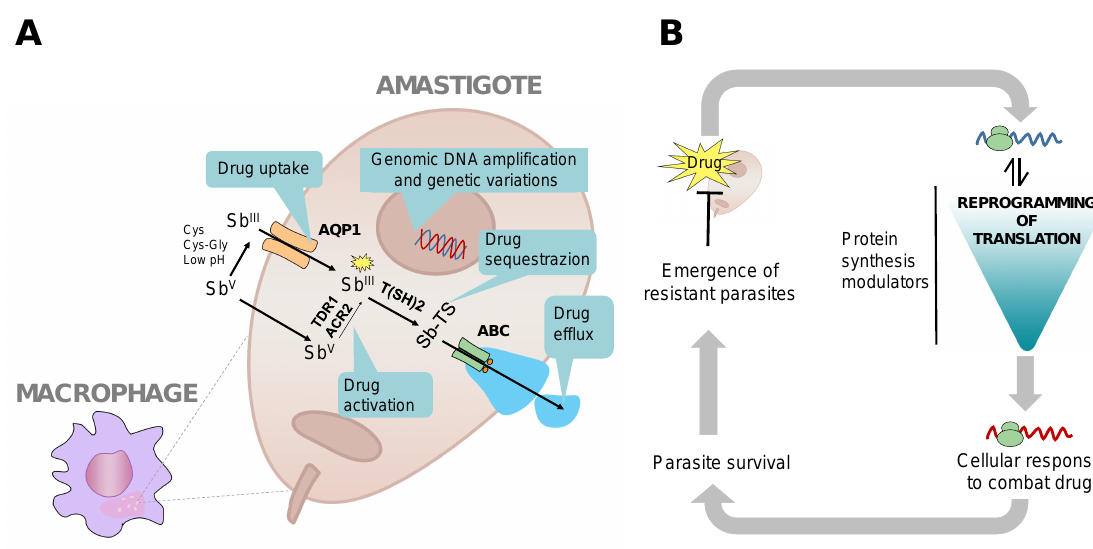
A schematic representation of Sb V resistance in Leishmania parasites. ( A ) Genomic amplifications, mutations, and genetic variations contribute to Sb V resistance development. Several mechanisms can contribute to the drug resistance. Down-regulation of AQP1 blocks the drug uptake. Down-regulation of reductase enzymes prevents drug activation from Sb V to Sb III . Increase in drug sequestration can be achieved through action of thiol-metal conjugates (Sb III -TS). Changes in drug e ffl ux across ABC transporters and vesicles released by exocytosis also contribute to Sb V resistance phenotypes. ( B ) Scheme representing coordinated reprogramming of translational activity during the development of resistance to Sb V and other drugs. Once the drug pressure is initiated, the parasites sense the stress and initiate response. The translation is reprogrammed by modulation of proteins such as CDPK1 to combat the toxic action of drug. Some translational regulators could participate as a switch inducing or inhibiting the protein synthesis, prioritizing the production of essential proteins. These proteins could be involved in mRNA and protein stability, lipid metabolism, stress response and drug depuration / inactivation, promoting the parasite survival and drug resistance. Thiol-dependent reductase I (TDR1), As / Sb Reductase (ACR2), trypanothione (T(SH)2), aquaglyceroporin (AQP1), ATP-binding cassette (ABC), cysteine (Cys), cystein–glycine (Cys-Gly), and antimony-thiol conjugate (Sb-TS) are shown.